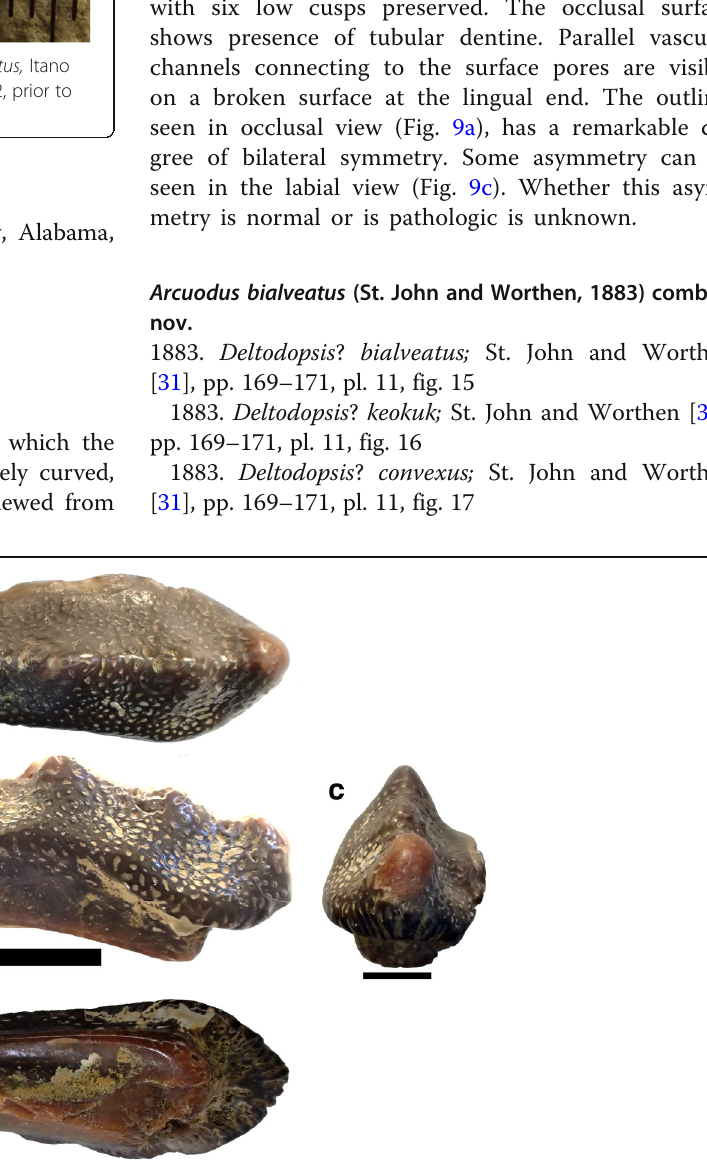
Fig. 9 Holotype of Arcuodus multicuspidatus. a Occlusal view. Lingual end to right. Scale bar = 5 mm. b Lateral view. Lingual end to right. Scale bar = 5 mm. c Lingual view. Scale bar = 2 mm. d Basal view. Lingual end to right. Scale bar = 5 mm